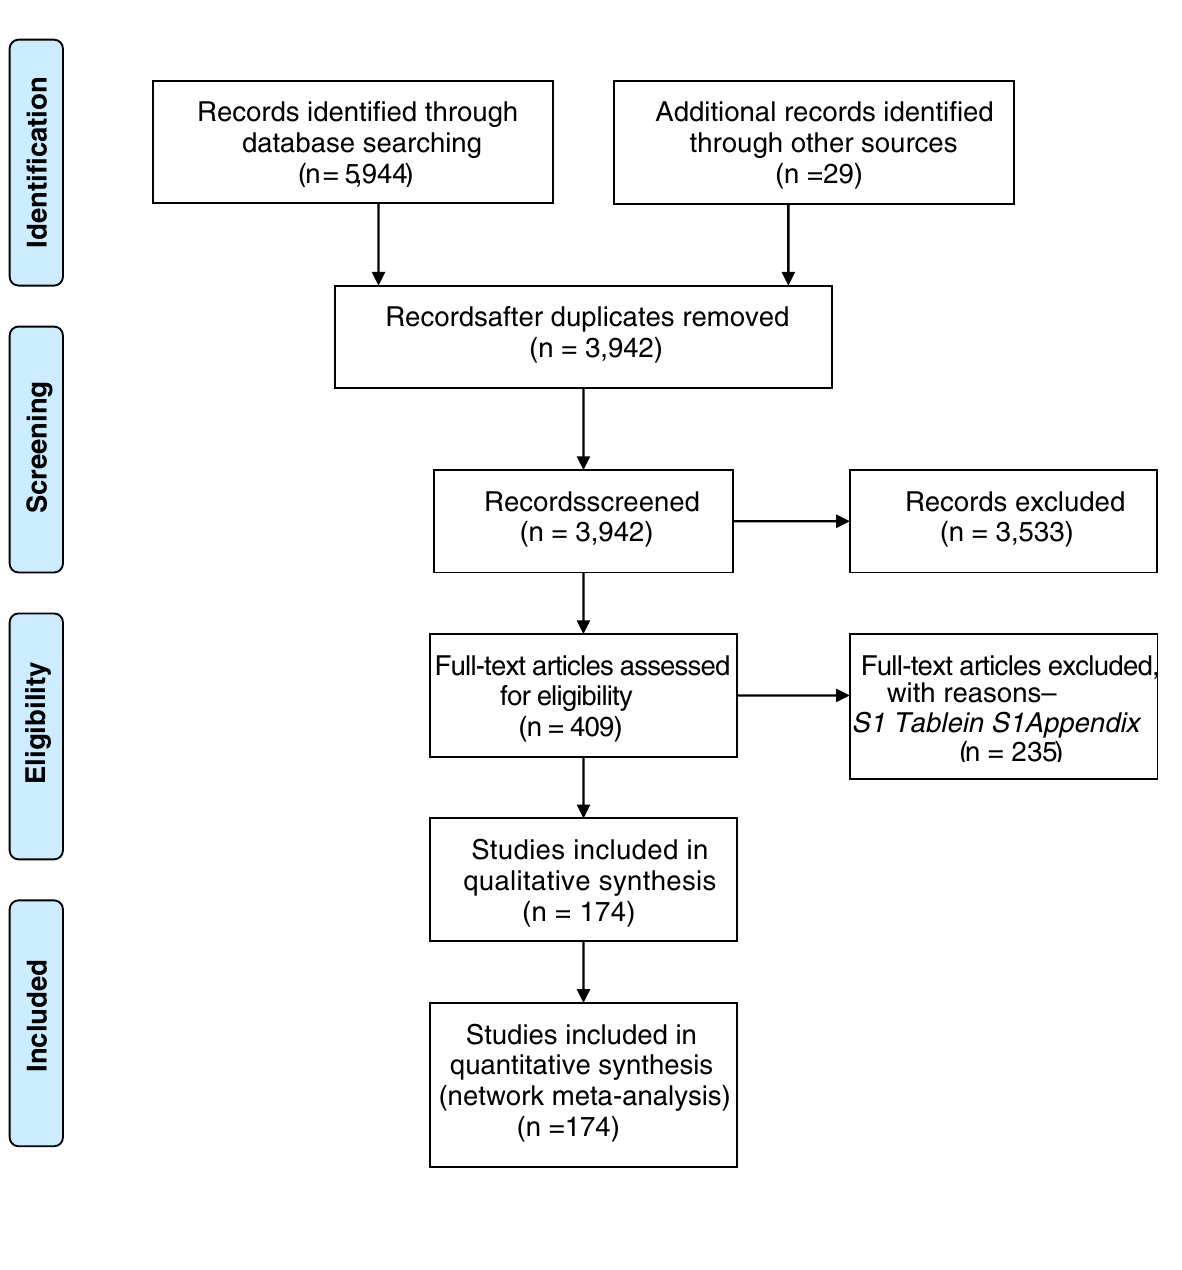
Fig 1. Article selection